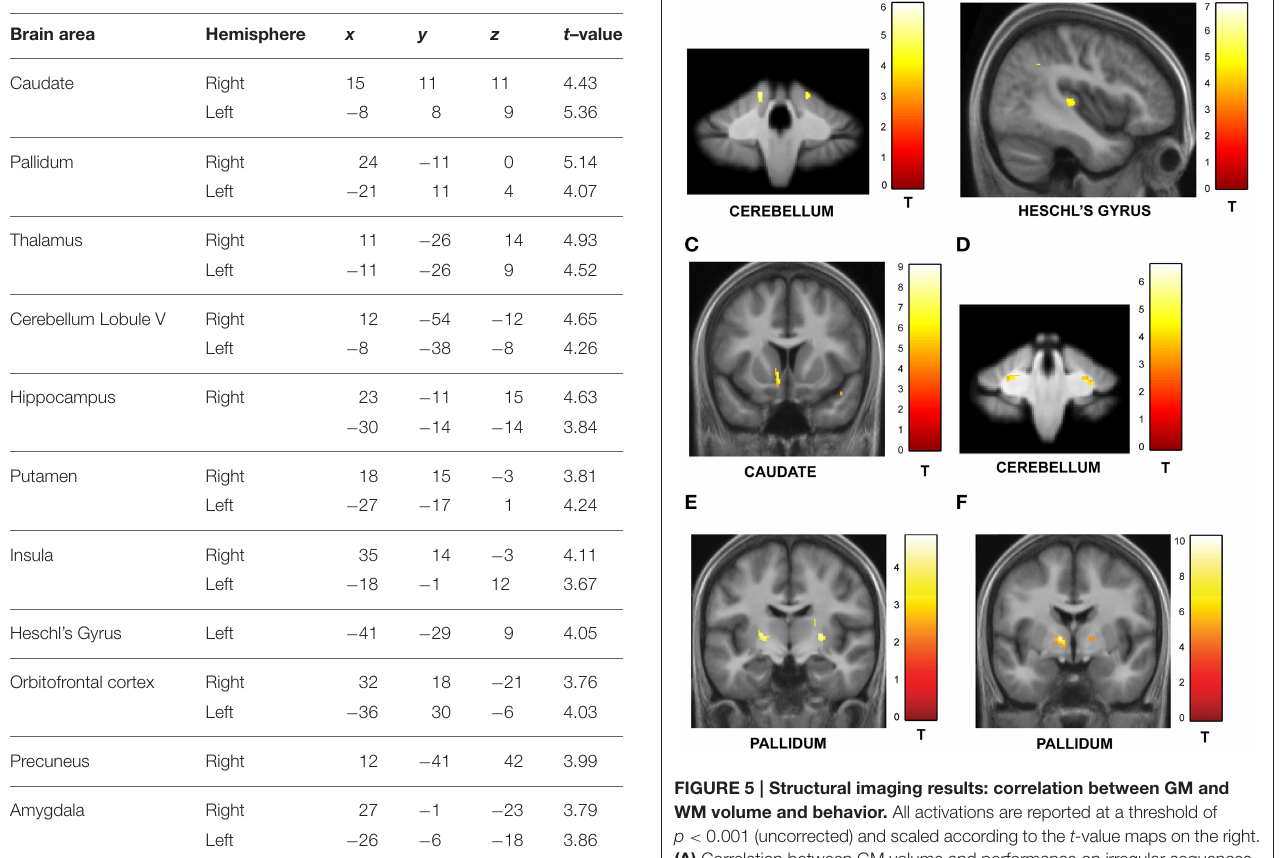
Local maxima are shown at p ≤ 0.001 (uncorrected). Table 3B | Brain areas activated for number-of-intervals vs. jitter condition. Brain area